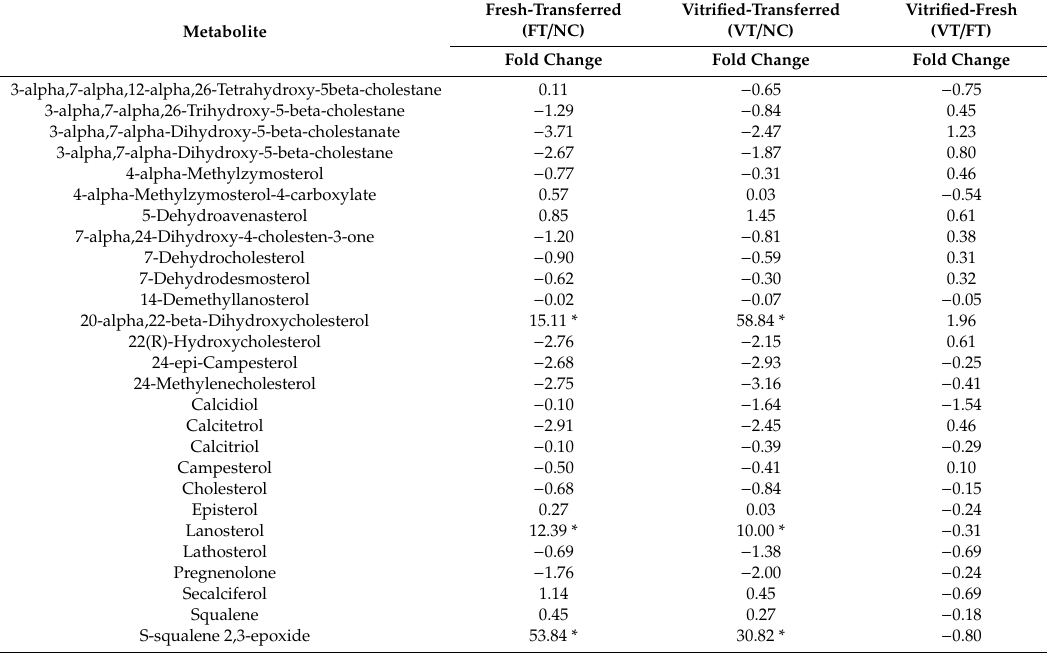
Table 1. Targeted identification of di ff erentially accumulated metabolites in liver tissue of prepuberal o ff spring born after embryo manipulation during the transfer procedure or vitrified embryos procedure compared to nonmanipulated in steroid biosynthesis pathway. Red indicates significant di ff erences. FT: fresh-transferred animals. NC: naturally conceived animals. VT: vitrified-thawed transferred